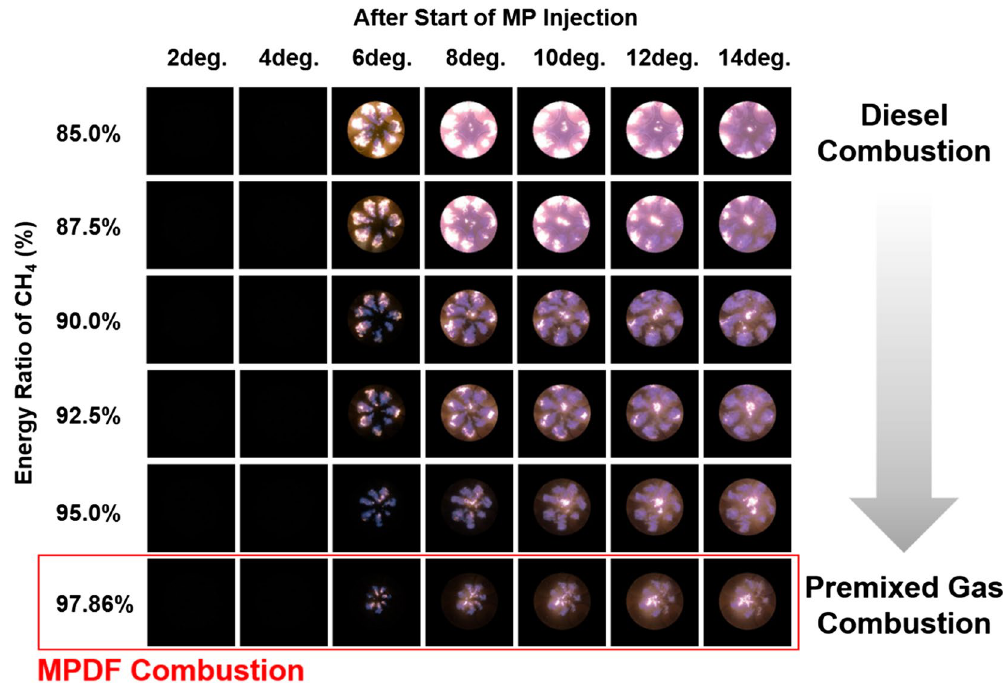
Figure 14. Combustion images depending on fuel mixture ratio.